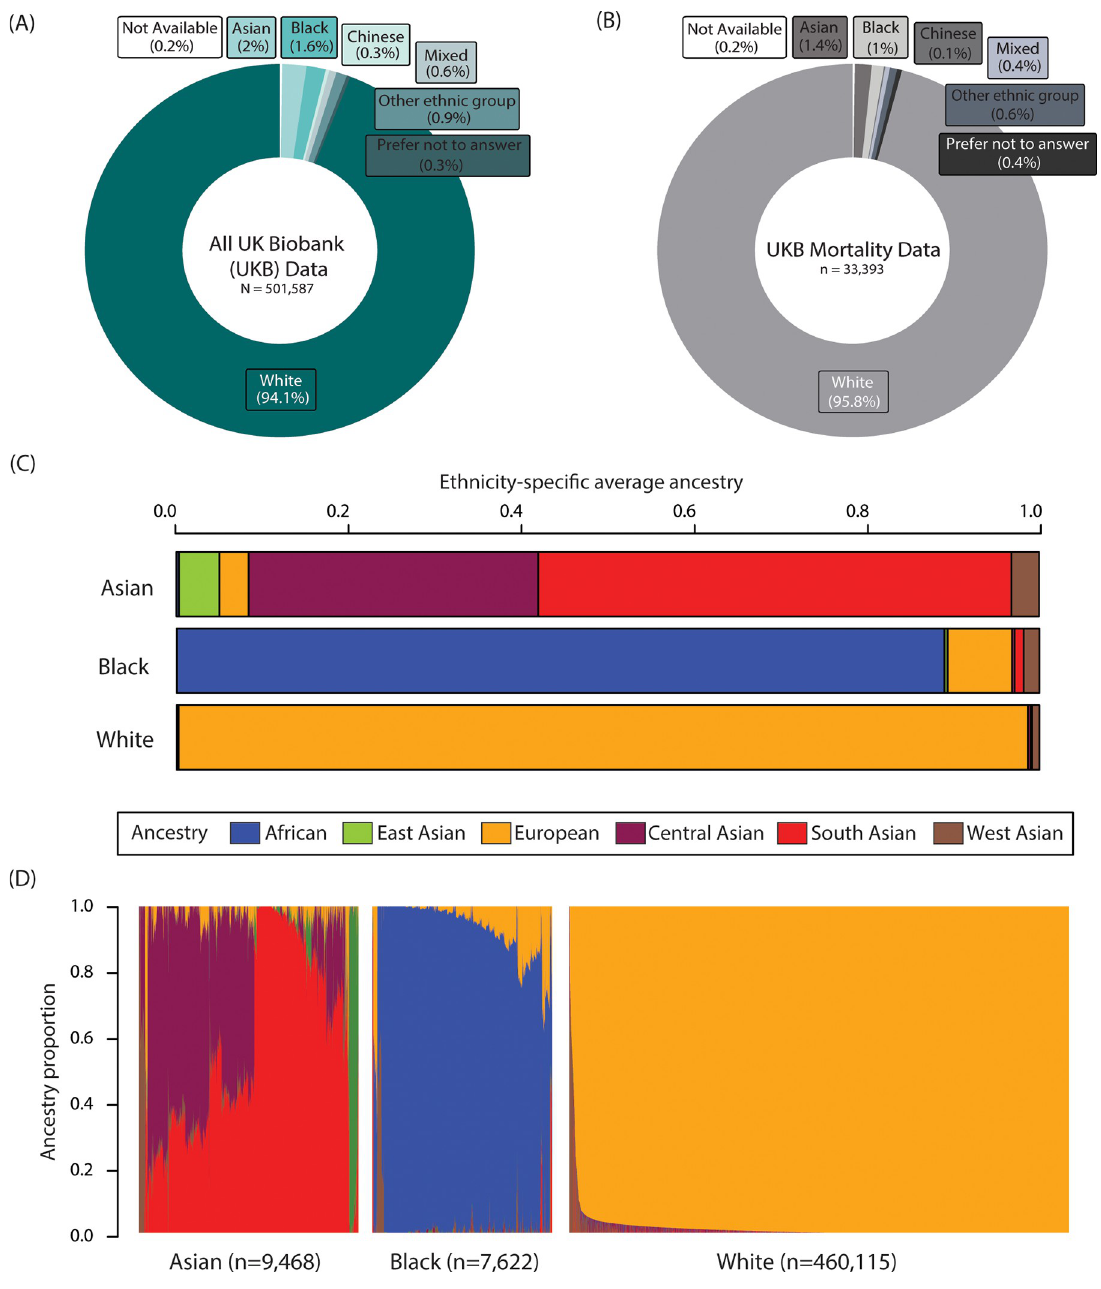
Fig 1. Ethnicity and genetic ancestry in the UKB. Participant ethnic group percentages for (A) the entire UKB cohort and (B) participants with mortality data. (C) Average genetic ancestry proportions for Asian, Black, and White ethnic groups. (D) Individual participant ancestry group proportions stratified by ethnicity. Continental ancestry group proportions are shown as: African (blue), East Asian (green), European (yellow), Central Asian (plum), South Asian (red), and West Asian (brown). CI = [1.236,2.066], p = 0.00035), while having infectious and parasitic diseases increased 95% the risk by nearly 2.5 times in Blacks (HR = 2.472 [1.829,3.342], p < 0.0001) (S4A Table). In contrast, operation on digestive organs including upper endoscopy and colonoscopy was the only type of in-patient procedures associated with reduced mortality risk in all three groups